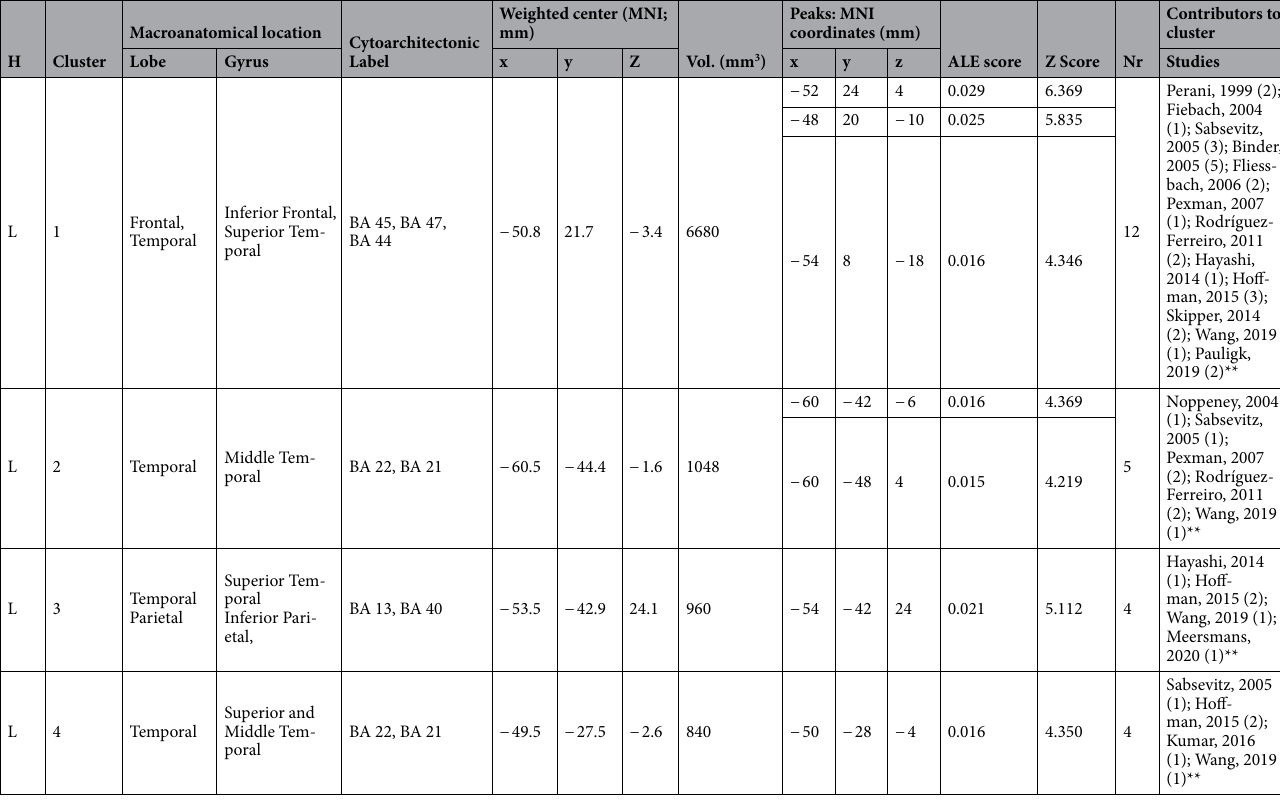
Table 6. Abstract > concrete word clusters. Included 146 stereotactic activation loci from 25 studies, 415 participants, chosen min. cluster size 704 mm 3 . All the values and labels were extracted from the GingerALE output files. Clusters are ordered for decreasing volume size. Coordinates (x, y, z) are in the MNI space. H = Hemisphere; ALE = activation likelihood estimation; Nr. = number of studies that contributed to each cluster; L = left; BA = Brodmann area; ** = between brackets are the number of foci from each study that contributed to that specific cluster.